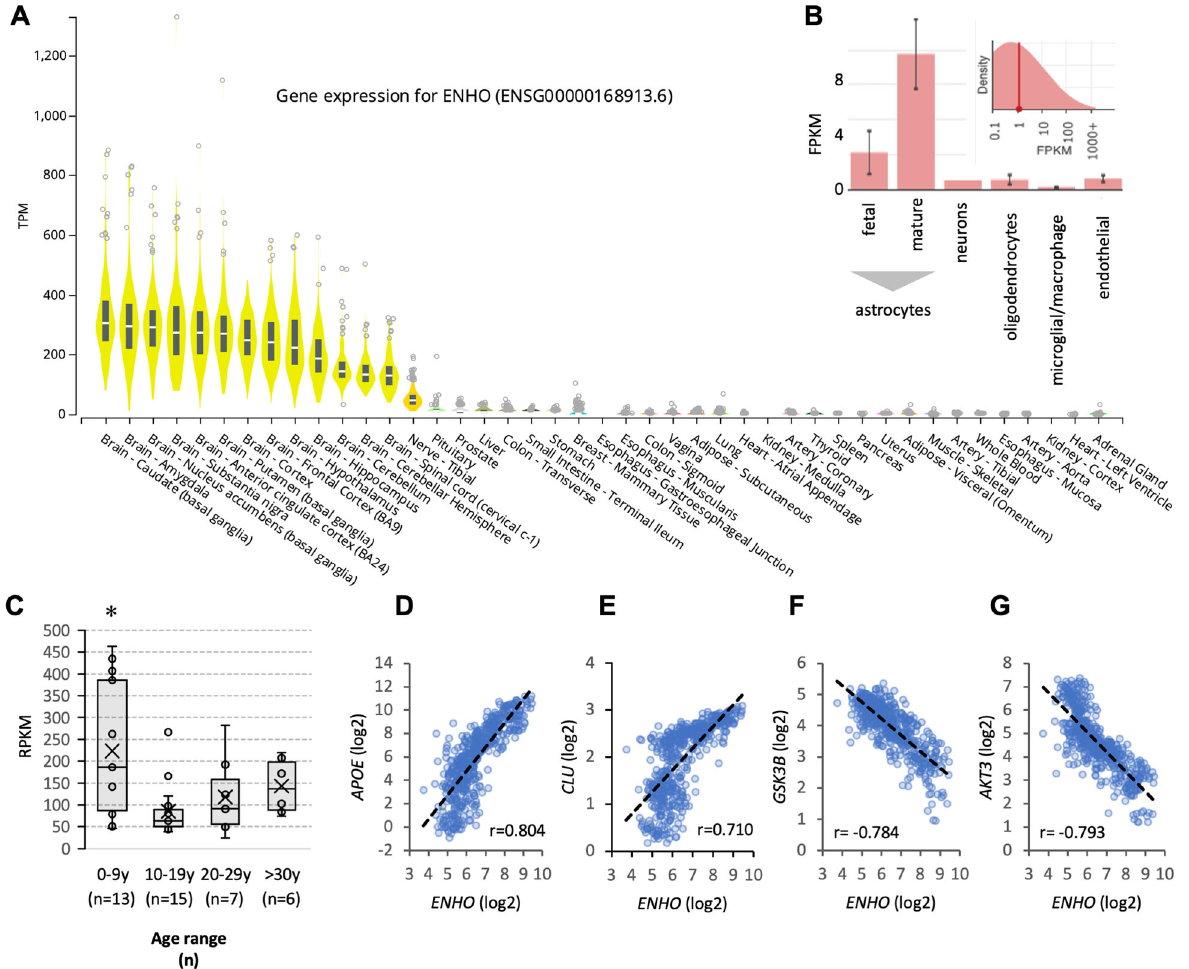
Fig. 1 ENHO expression in the human brain. A ENHO transcript expression (TPM) in human tissues ranked high to low reading left to right (GTEx). B ENHO expression in isolated cell populations (brain.org). C ENHO expression by age group. This analysis used data from 41 individuals (mean ± SD for age, 15.8 ± 11.2 y, range 4 mo – 40 y; 22 males, 14.3 ± 11.7 y, 4 mo – 37 y; 19 females, 17.5 ± 10.6 y, 1 – 40 y) downloaded from The Atlas of the Developing Human Brain 28,30 . Multiple samples from different brain regions were obtained from individuals; mean expression for samples from individuals was used for the analysis. Data were pooled into 10-year bins (birth-9 y, 10 – 19 y, 20 – 29 y, and >30 y). * p < 0.05 vs. all other groups combined. D – E Expression of APOE ( D ), Clusterin/ApoJ ( E ), GCK3B ( F ), and AKT3 ( G ) related to ENHO (524 samples from 41 individuals, data from The Atlas of the Developing Human Brain 28,30